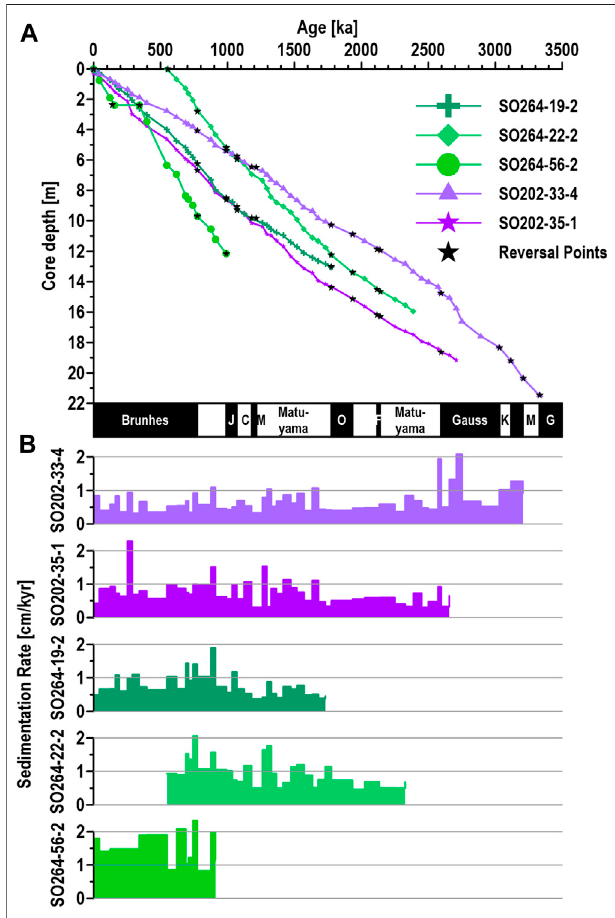
FIGURE9|(A) Finalizedage-depthmodelsand (B) linearsedimentation rates after RPI correlation. Black stars represent reversal-based tie-points. Black (white) bars at the bottom of the panel indicate normal (reverse) polarity zones. Magnetostratigraphic abbreviations are explained in the caption of Figure 6